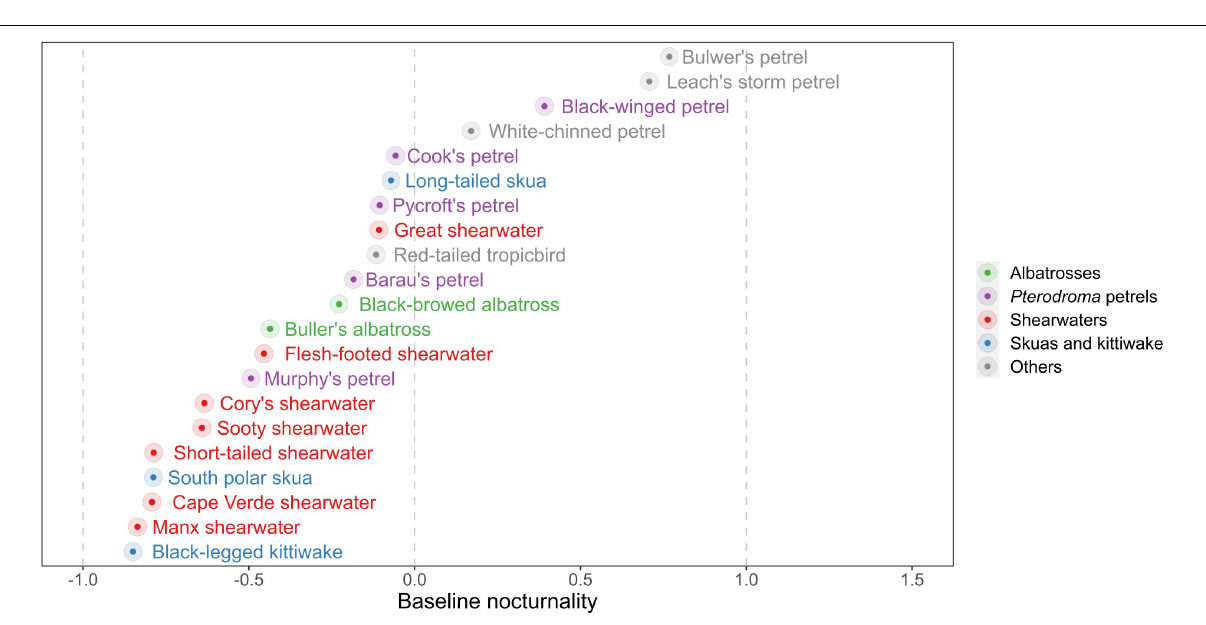
FIGURE 4 | Night flight index during the non-breeding period averaged across days and individuals (coloured dots). Negative values correspond to diurnal species (i.e., species which fly more during daylight than darkness), while positive values are for nocturnal species (i.e., species which fly more during darkness than daylight). For exact values and standard deviations, see Supplementary Table 5